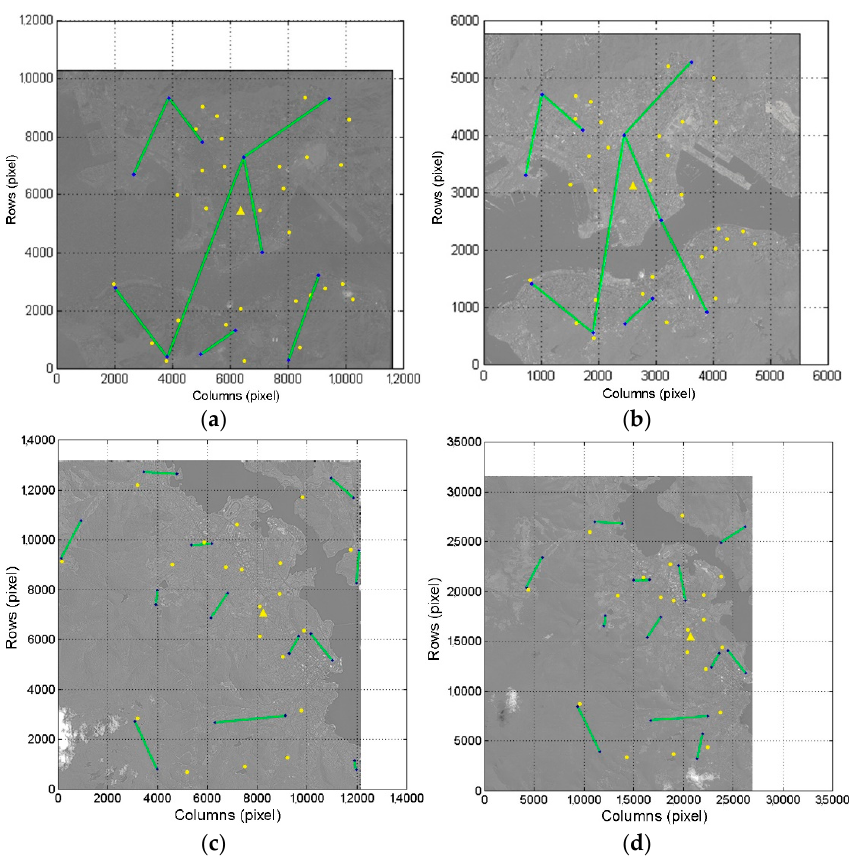
Figure 4. Distributions of the control conditions of Control Schemes I to IV on four HRSI datasets: ( a ) control conditions of Control Scheme I; ( b ) control conditions of Control Scheme II; ( c ) control conditions of Control Scheme III and ( d ) control conditions of Control Scheme IV. On each subfigure, green line segments represent control lines; blue dots represent control points, which construct the control lines; yellow triangles represent single GCP; and yellow dots represent check points.